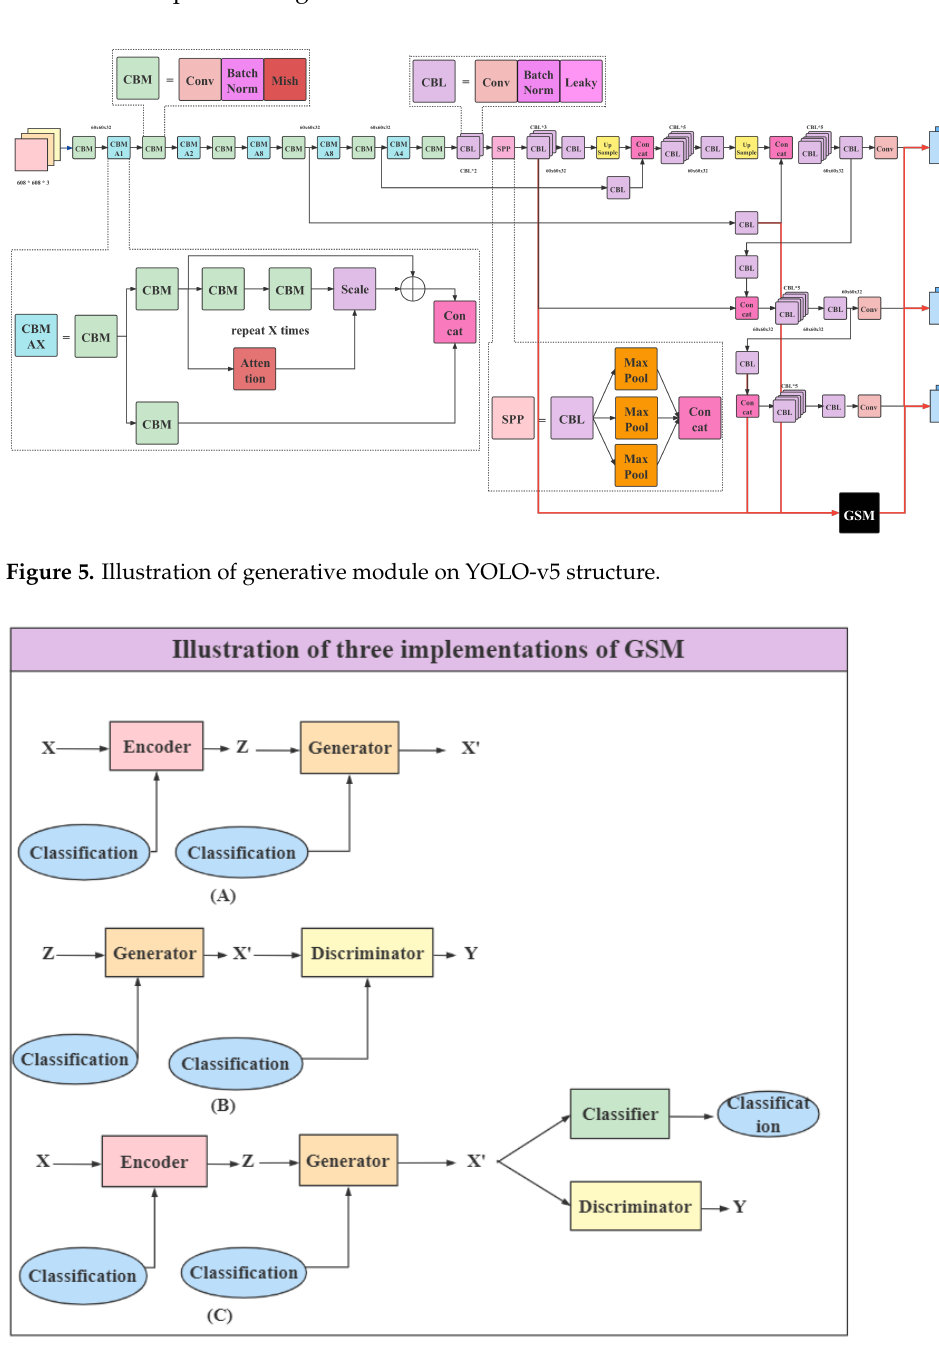
Figure 6. Illustration of three implementations of generative